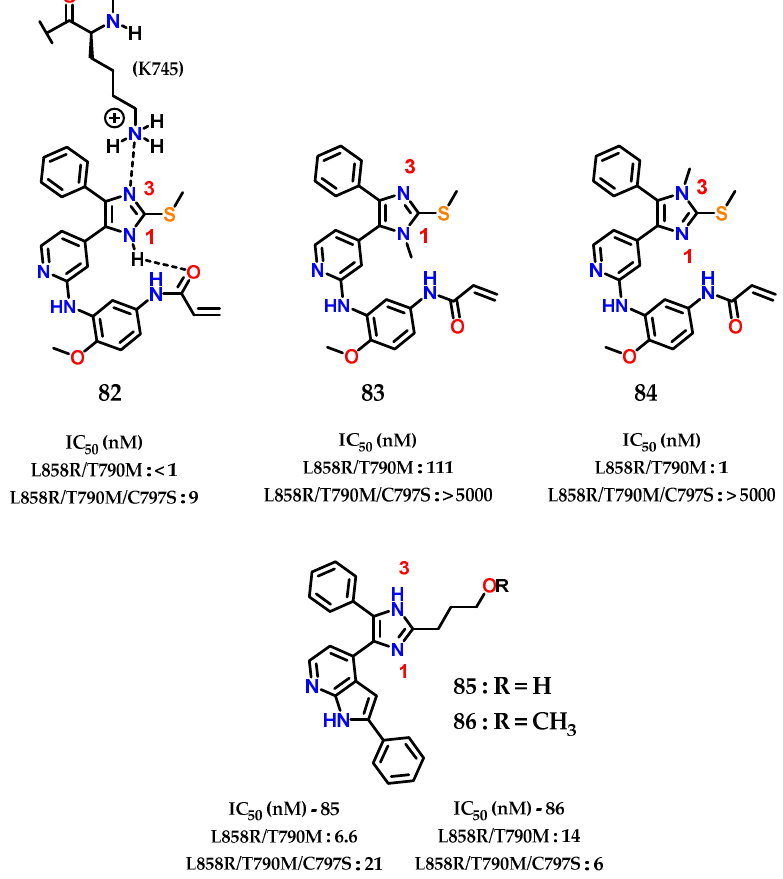
Figure 34. EGFR(L858R/T790M) and EGFR(L858R/T790M/C797S) imidazole